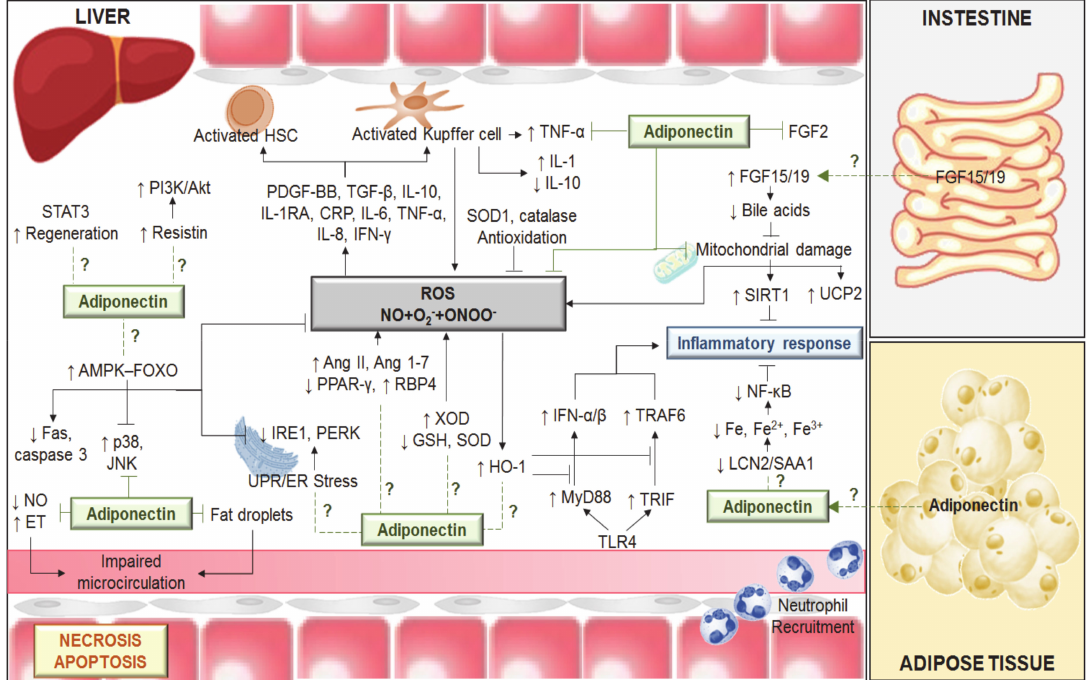
Figure 1. Mechanisms involved in the e ff ects of adiponectin in di ff erent liver diseases including hepatic I / R. Ischemia-induced energy deficiency results in the failure of active transmembrane transport and consequently in endothelial cell (EC) and Kup ff er cell (KC) swelling. KC activation results in